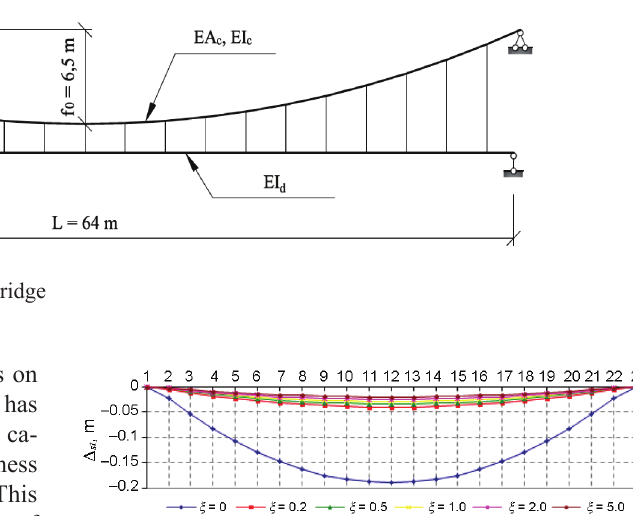
Fig. 4. Curves of a vertical displacement under the self-weight load versus the stiffness parameter x of the